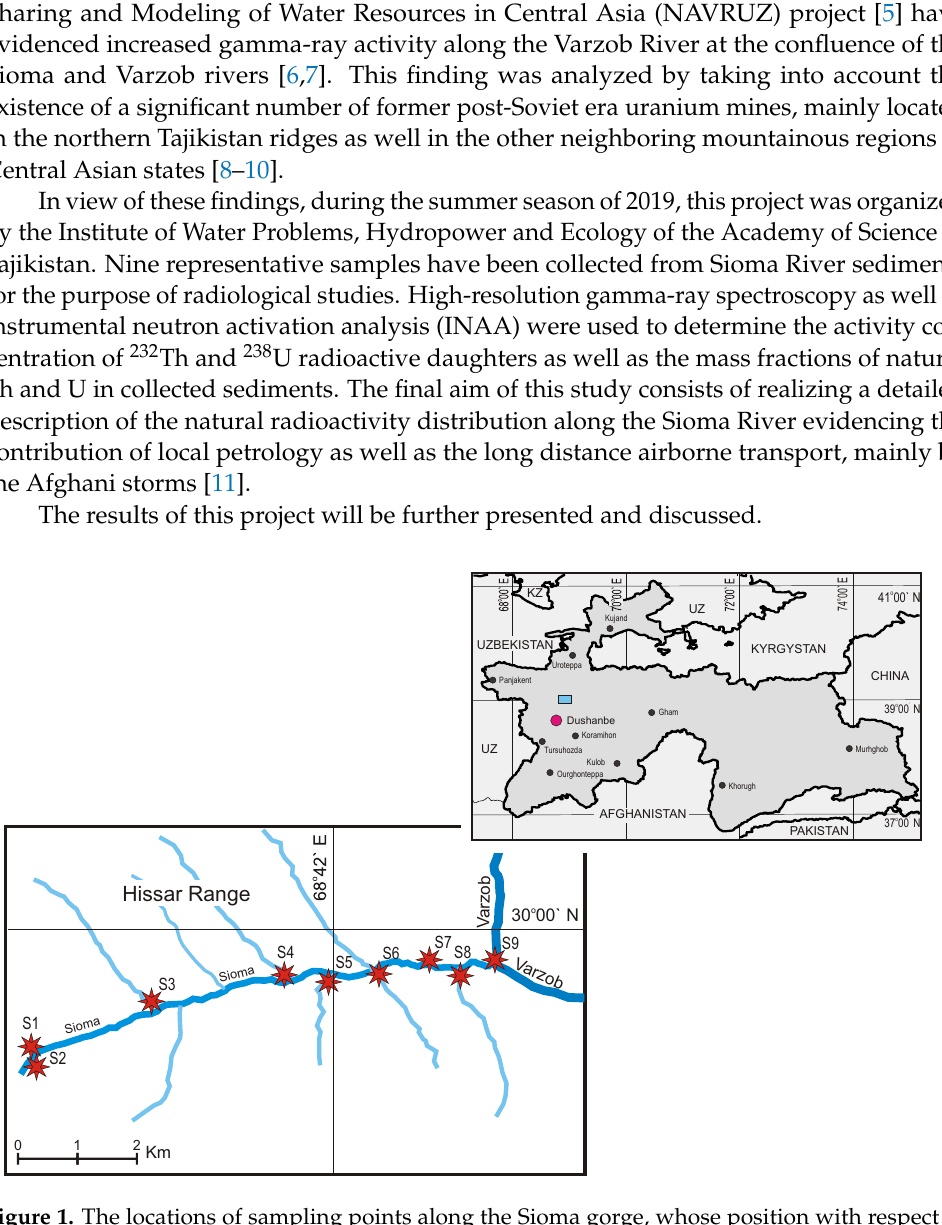
Figure 1. The locations of sampling points along the Sioma gorge, whose position with respect to Tajikistan is illustrated in the inset. The tributaries of the Sioma River are, in fact, small creeks, the majority without